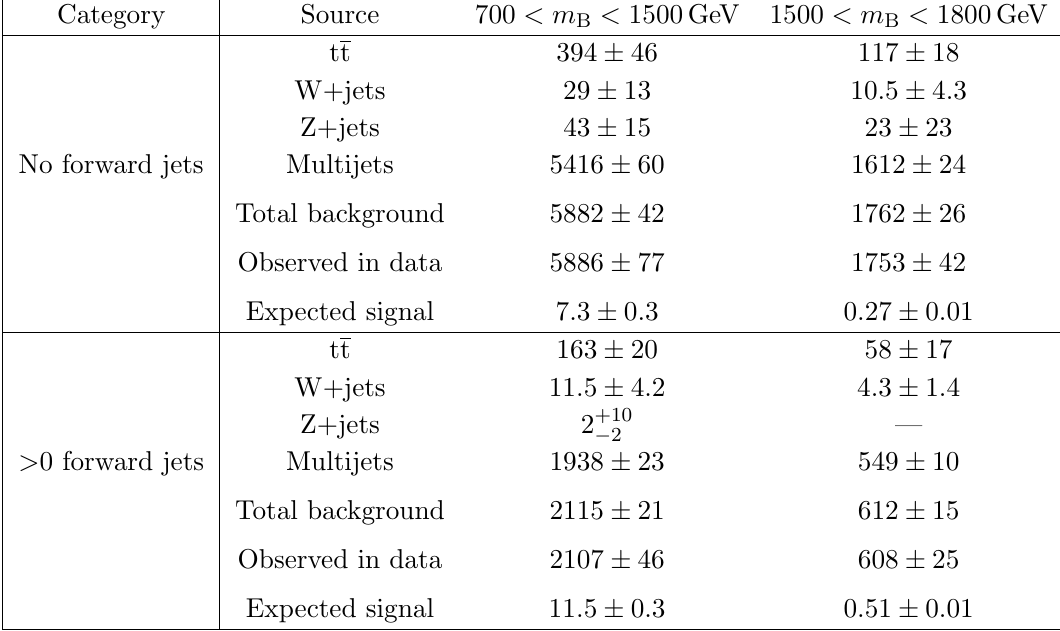
Table 4. Observed and expected (cid:12)tted number of events in the signal ranges of 700 < m B < 1500 and 1500 < m B < 1800 GeV, and expected signal at m B = 1000 and 1800 GeV. The multijet background is obtained from data, while the yields for the other sources of background are obtained from MC simulation. The combined statistical and systematic uncertainties correspond to the quadrature of the statistical and systematic